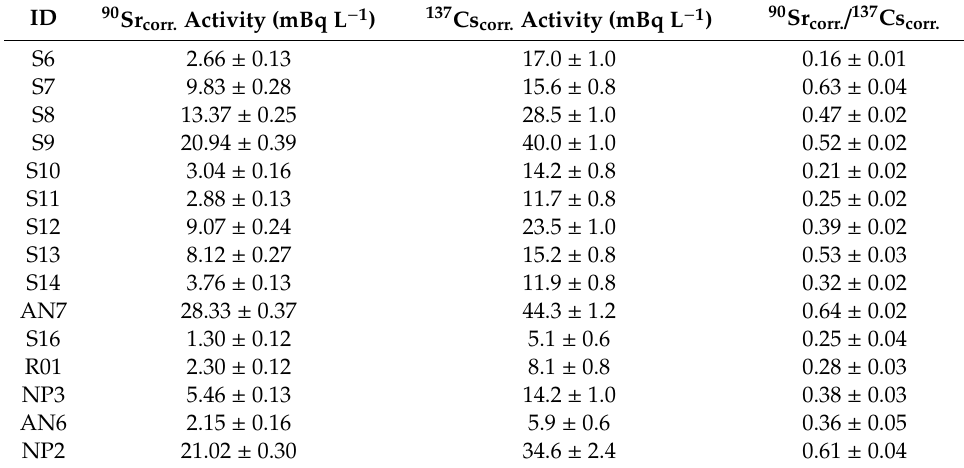
Table 2. FDNPP site-derived 90 Sr ( 90 Sr corr. ) and 137 Cs ( 137 Cs corr. ) activities and 90 Sr corr. / 137 Cs corr. activity ratios.